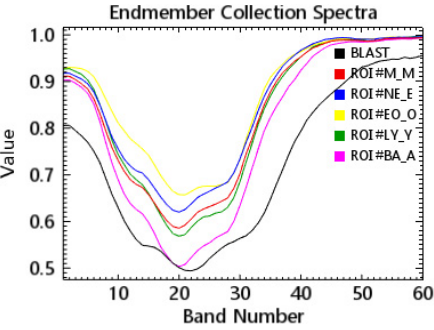
Fig. 5. Spectra of healthy leukocytes and lymphoblast